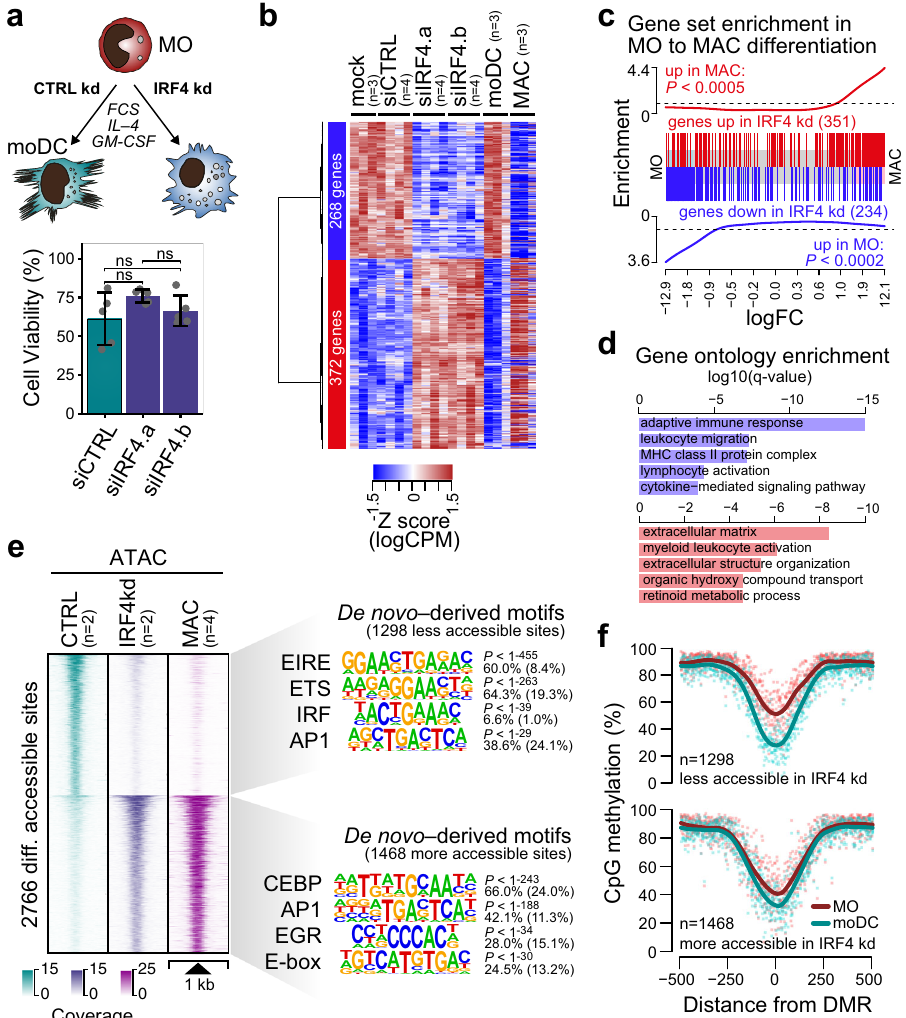
Fig. 4 Effect of IRF4 knock-down on MO differentiation. a Schematic of the experimental setup and effect of siIRF4 treatment on moDC viability. Bars in the bottom panel represent mean ± SD of n = 5 biologically independent experiments. Individual data points are shown as gray dots (ns, not signi fi cant, paired t -test, two-sided). b Heatmap presenting hierarchically clustered and scaled expression data of differentially expressed genes in control- (mock, siCTRL) versus siIRF4-treated cells (absolute logFC > 1, logCPM and logRPKM > 1, and FDR < 0.05). Each column corresponds to an individual donor. For comparison, expression data of independent cultures of moDC and MAC were included into the heatmap before scaling. c Barcode plots showing the enri c hment of the indicated gene sets (red: up in siIRF4-treated cells; blue: in siIRF4-treated cells) across the logFC ranked gene list of MO to MAC differentiation. Enrichment P -values of two-sided rotation gene set tests are given. d Gene Ontology (GO) terms associated with genes upregulated (red bars) or downregulated (blue bars) in siIRF4-treated compared to control-treated cells, as analyzed by Metascape. Bars represent corrected, log- transformed P -values ( q- values) of the GO term enrichment. e Distribution of ATAC-seq signals across the differentially accessible sites between control- and siIRF4-treated samples. ATAC-seq signals of MO-derived MAC are plotted across the same regions for comparison. De novo-derived motifs for each cluster are given along with the signi fi cance of motif enrichment (hypergeometric test) and the fraction of motifs in peaks (background values are in parenthesis). Top motifs corresponding to known factor families are shown for each cluster. f Genomic distance distribution o f averaged DNA methylation ratios in MO and moDC centered on differentially accessible sites (as introduced in ( d )). ( a – f ) Source data are provided as a Source Data fi le.